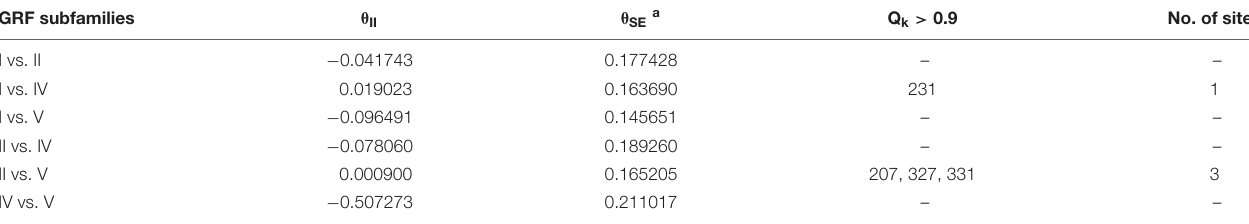
TABLE 2 | Analysis of type II functional divergence. GRF